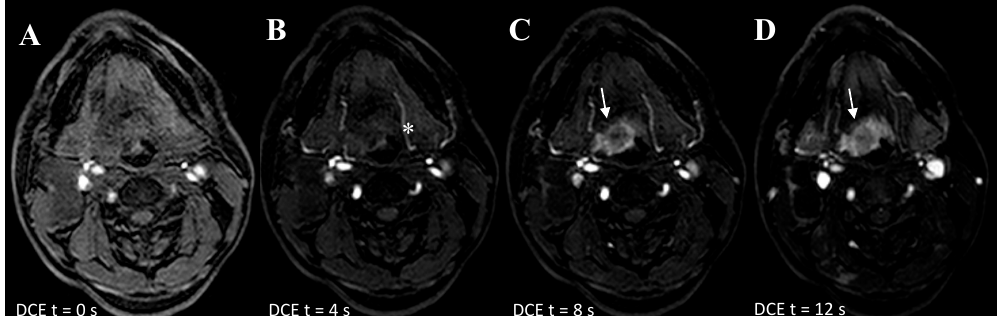
Figure 2. Ultra-fast DCE in a 53-year-old patient with an overt primary tumor in the tongue base. ( A ) at T = 0 seconds is the first frame in which the contrast enters the carotid and vertebral arteries. ( B ) At T = 4 seconds later, the contrast flows in the arterial branches of the external carotids (*). ( C ) At T = 8 seconds the contrast agent has ‘washed-in’ the hypervascular malignant lesion at the base of tongue (arrow). ( D ) At T =12 seconds, the contrast agent is still in the hypervascular lesion. At this stage, the surrounding oropharyngeal mucosa show also contrast enhancement ( Δ ).